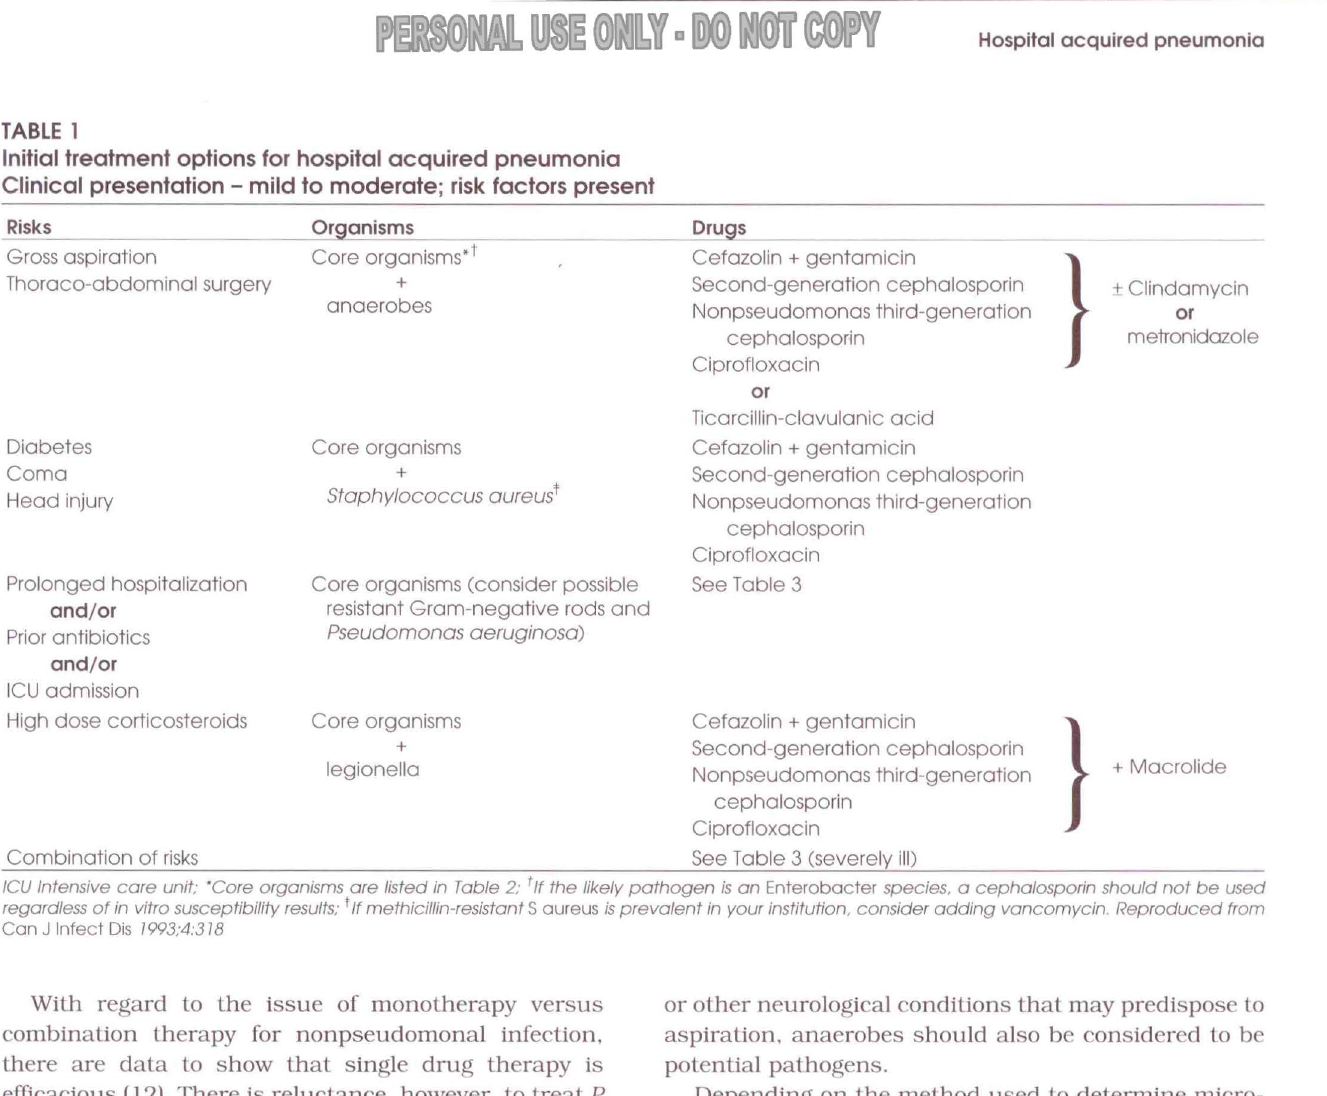
Initial treatment options for hospital acquired pneumonia Clinical presentation - mild to moderate; risk factors present